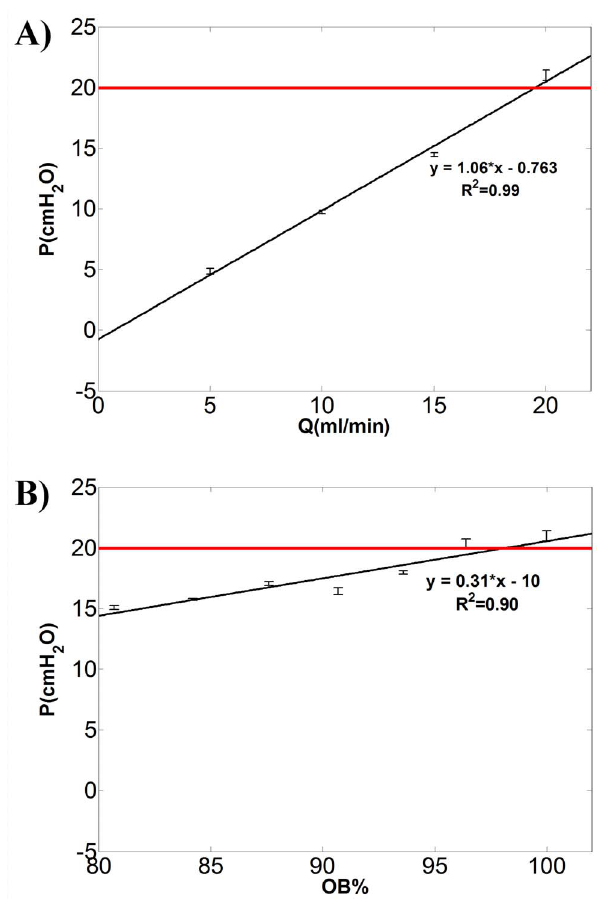
Figure 5. Renal pelvic pressure vs urine properties and severity of obstruction. Renal pelvic pressure ( P ) in the ureteric model increases linearly with A) flow rate ( Q in ml/min) and B) severity of obstruction in the upper UM (OB%, calculated using Eq. 1). Fixed values of OB%=100 and Q =20 ml/min were considered for the experimental data reported in A) and B), respectively. The fluid dynamic viscosity is equal to 1 cP. The equation of the least square regression line, the R- squared values and error bars are reported (N=3). The slope of regression line in panel A represents the hydraulic resistance of the system. The horizontal red line indicates the critical value of renal pelvic pressure ( P =20 cmH 2 O).